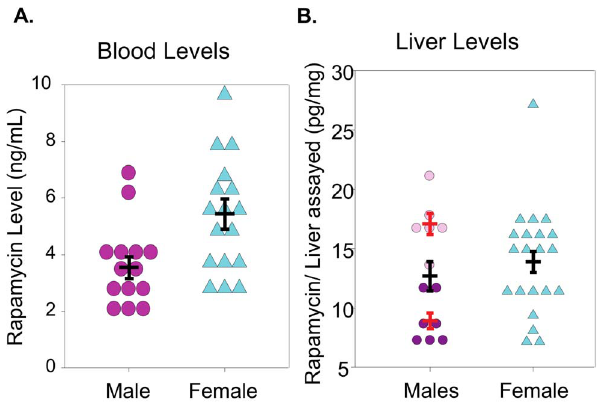
Figure 2. Rapamycin levels in the blood and liver of mice fed rapamycin. Rapamycin levels were measured in mice fed rapamycin starting at 4 months of age using HPLC-mass spectrometry, and the data are presented as ng Rapa per ml of blood or pg Rapa per mg of liver. Graph A shows blood levels measured 10 months of age and Graph B shows liver levels measured at 25 months of age for liver. The values for each mouse are shown as follows: females (cyan triangles), Rapa-1 males (dark pink circles) Rapa-2 males (pink circles), and total Rapa males in blood (magenta). The red bars indicate mean 6 SEM for Rapa-1 and Rapa-2 males while the black bars indicate mean 6 SEM for the all the Rapa male and Rapa female mice. The data were statistically analyzed using the student T-tests with blood Rapa male versus Rapa female giving a p-value of p=0.006, liver Rapa-1 males versus Rapa-2 males giving a p-value of p , 0.001, and the liver Rapa male (total) vs. Rapa female giving a p-value of 0.46.